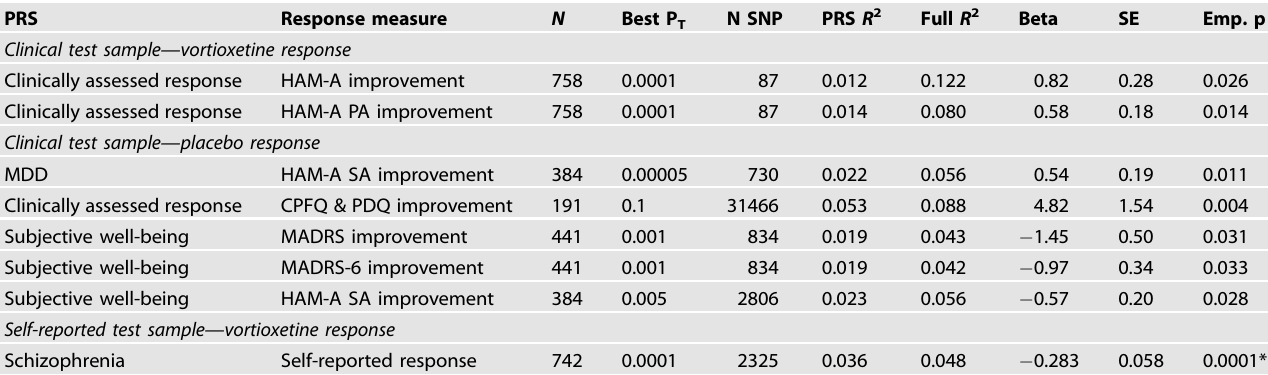
Table 2. Associations with an empirical p -value < 0.05 between PRS for antidepressant response, psychiatric disorders, and symptom traits and placebo and vortioxetine response in the clinical test sample and the self-reported test